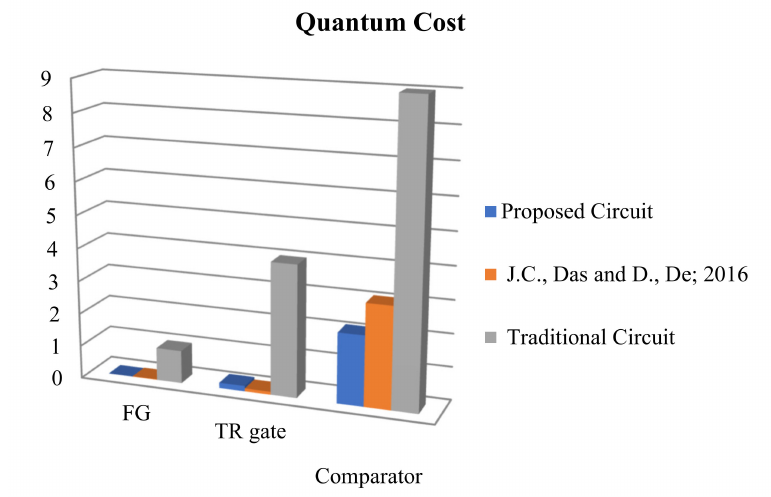
Figure 15. Quantum cost for the proposed circuits